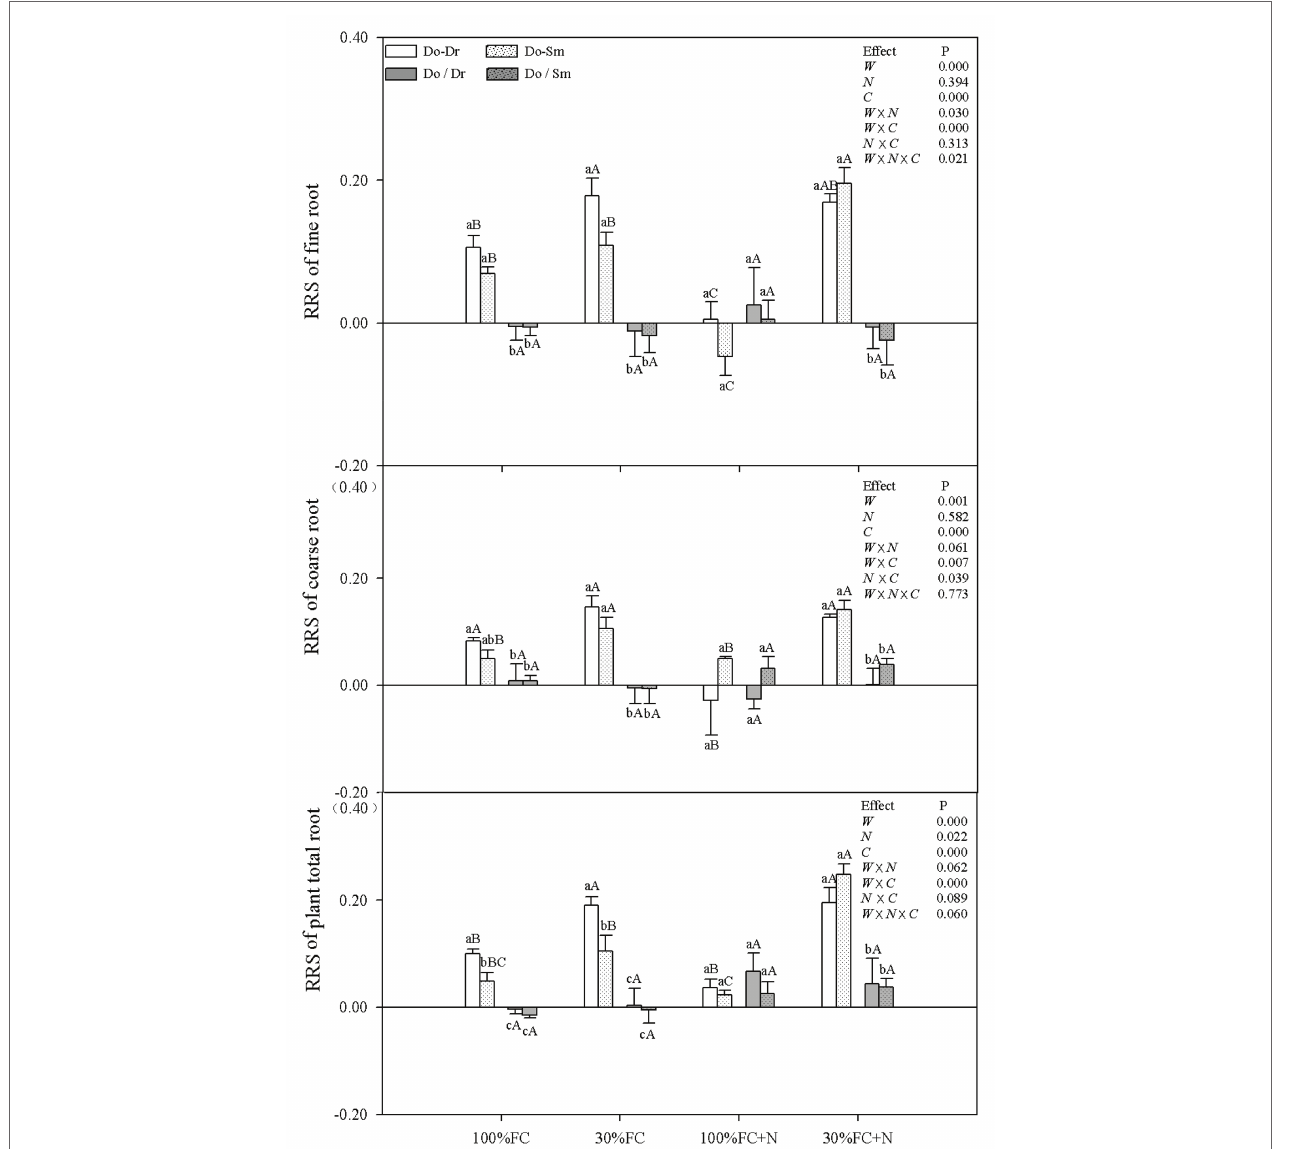
FIGURE 6 | Effects of water, N fertilization levels on RRS of D. odorifera in the total root, fine root, and coarse root in different species competition models. Different lowercases in each graph indicate significant difference among different competitive models (competition between D. odorifera and various N-fixing niche neighbors) under the same water and N application according to Duncan’s tests ( p < 0.05). Different uppercases in each graph indicate significant difference among different water and N fertilization application in the same competitive models according to Duncan’s tests. For abbreviations explanation of treatments (species competition models, water, and N fertilization), data description, and statistics are the same as shown in Figure 5